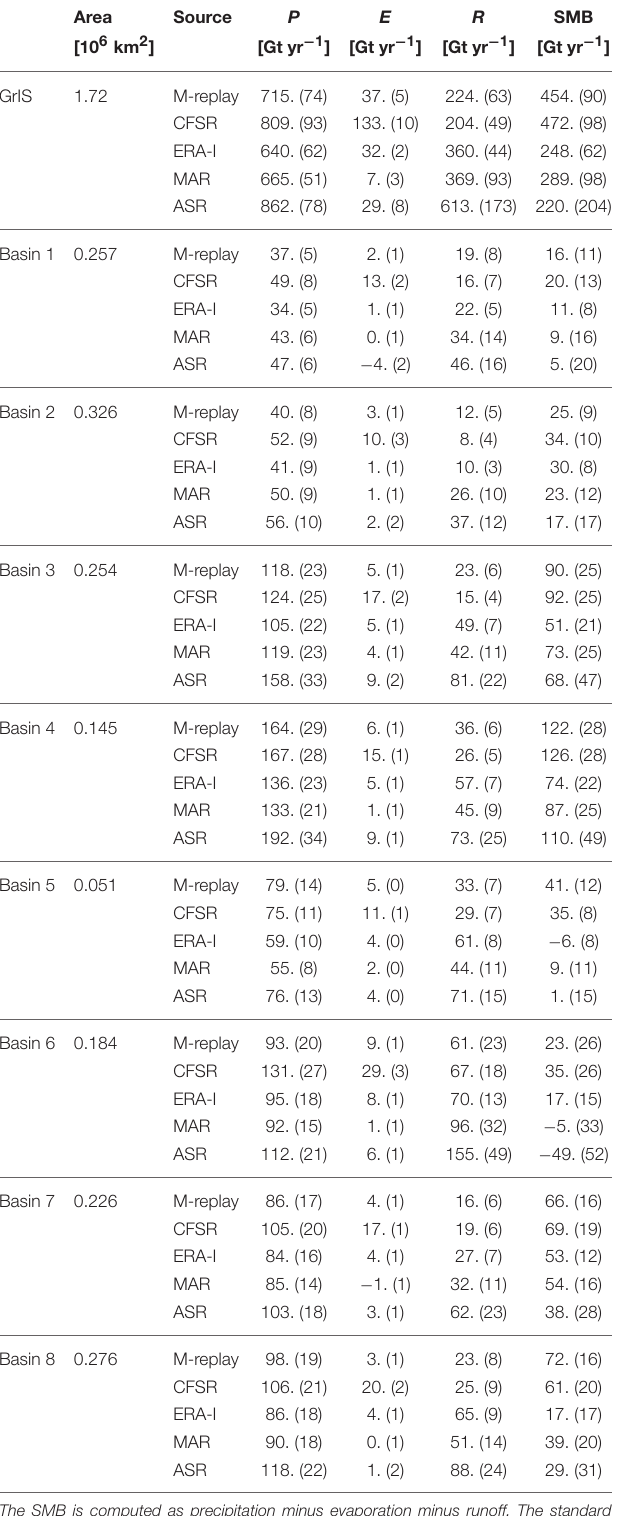
TABLE 2 | Precipitation (P), evaporation (E), runoff (R), and computed SMB for the GrIS and drainage basins as defined by Zwally et al. (2012) from five models for the period 2000-2012, in Gt yr − 1